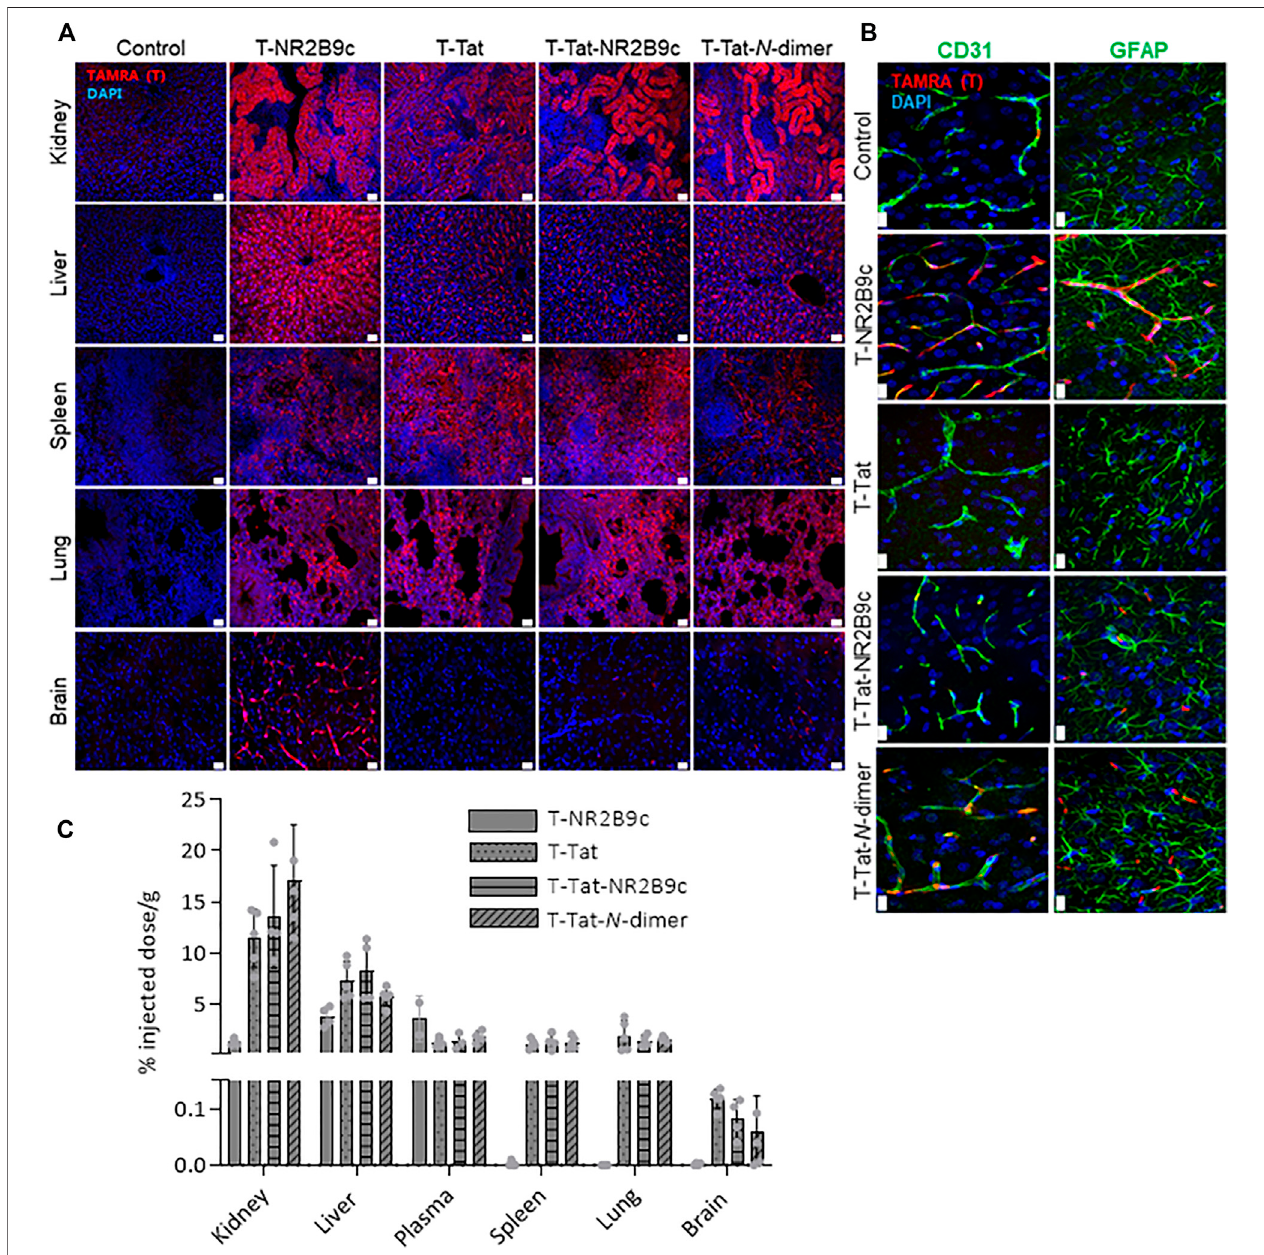
FIGURE 6 | Fluorescent microscopy images of biodistribution of T-NR2B9c, T-Tat, T-Tat-NR2B9c, and T-Tat- N -dimer in rat tissue cryosections after tail vein administration of 3 nmol peptide/g body weight and 40-min circulation. (A) Peptide uptake in the kidney, liver, spleen, lung, and brain was visualized via TAMRA fl uorescence(red),whereascellnucleiwerestainedwithDAPI(blue). (B) BrainsectionswereimmunostainedwiththeendothelialmarkerCD31(leftpanel,green)andthe astrocyte marker GFAP (right panel, green). Red, TAMRA; blue, DAPI. Scale bar: 20 µm. (C) Peptide uptake in the kidney, liver, spleen, lung, and brain was quanti fi ed using fl uorescence spectroscopy via TAMRA fl uorescence. Data are presented as % injected dose/g with mean ± SD ( N = 4 – 5).